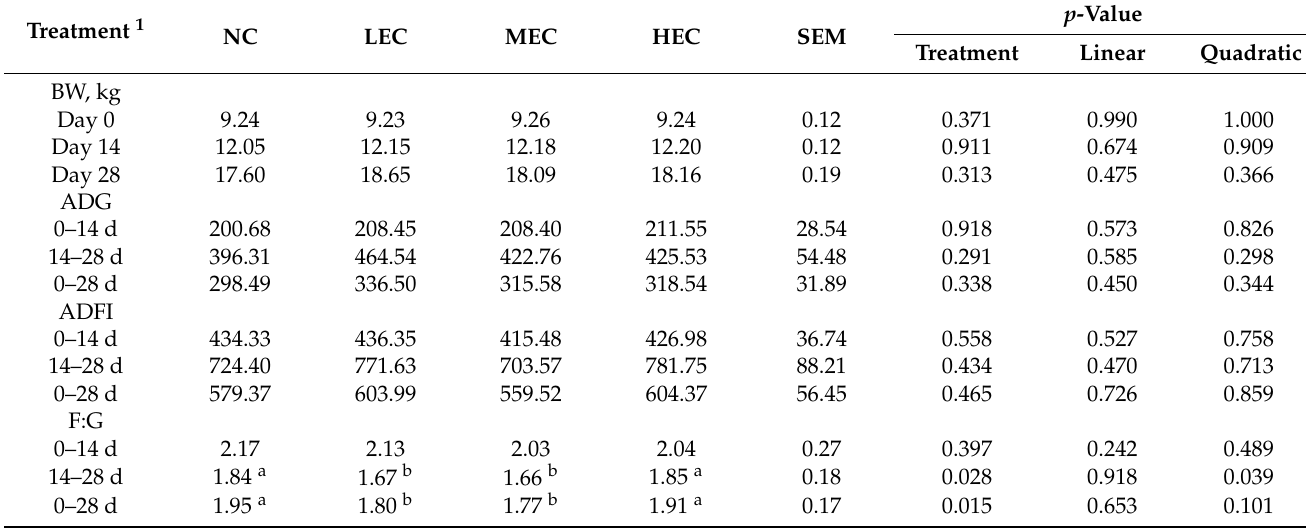
Table 4. Effect of different gelatinization degree of extruded corns on growth performance of piglets in experiment